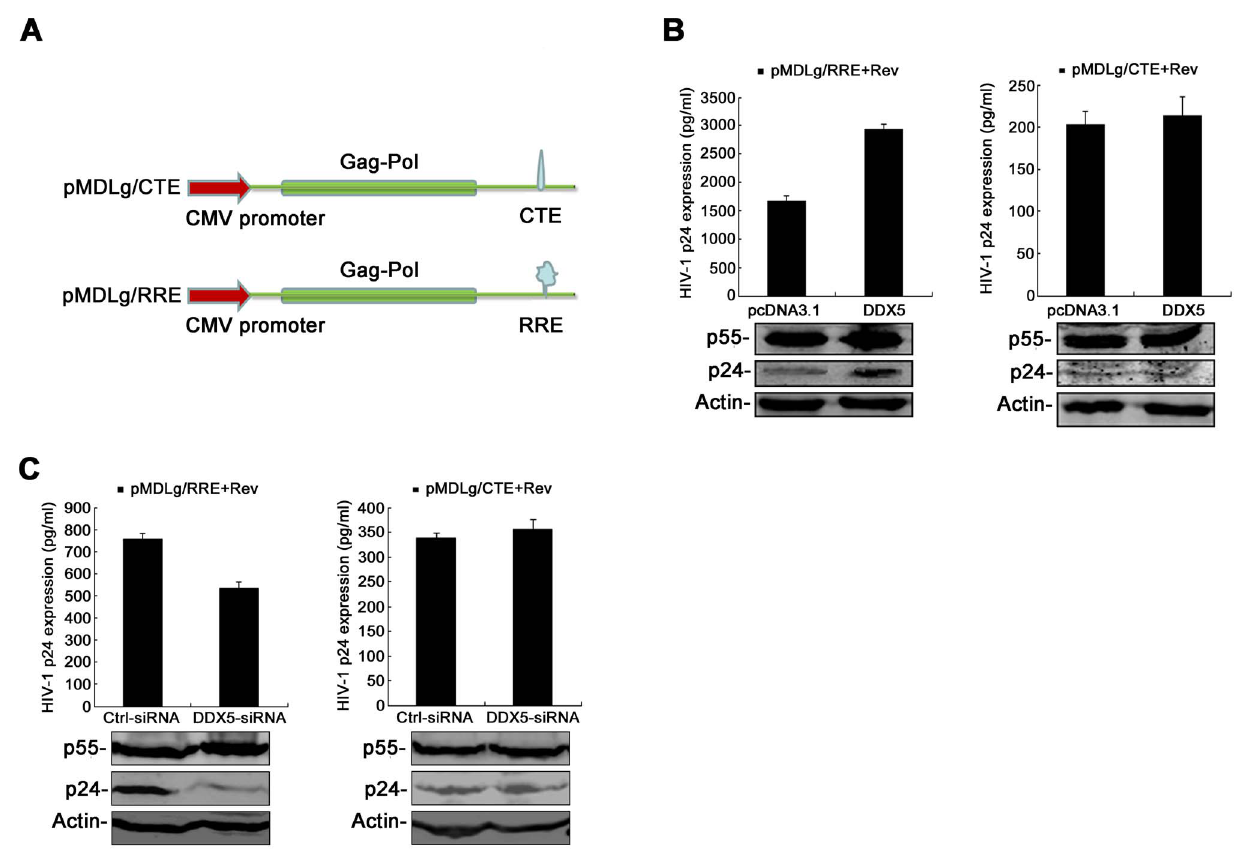
Figure 3. DDX5 modulates Rev/RRE- but not CTE-dependent reporter gene expression. A . Schematic maps of pMDLg/CTE and pMDLg/ RRE. B . The 293T cells were co-transfected with pMDLg/RRE (or pMDLg/CTE), pcDNA3.1-Rev and pcDNA3.1-DDX5-HA (pcDNA3.1 as a control). C . The 293T cells were co-transfected with pMDLg/RRE (or pMDLg/CTE) and pcDNA3.1-Rev in the presence of DDX5-siRNA (GFP-siRNA as a control). B and C . The supernatants were collected for assay of HIV-1 p24 ELISA at 48 h p.t. Western blotting analysis was performed to confirm p55 Gag expression with anti-p24 antibody. The results are mean values with 6 S.D. from triplicate samples.